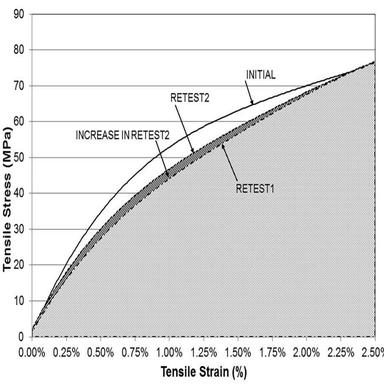
Material energy method: area under Retest2 curve representing self-healing that has occurred.